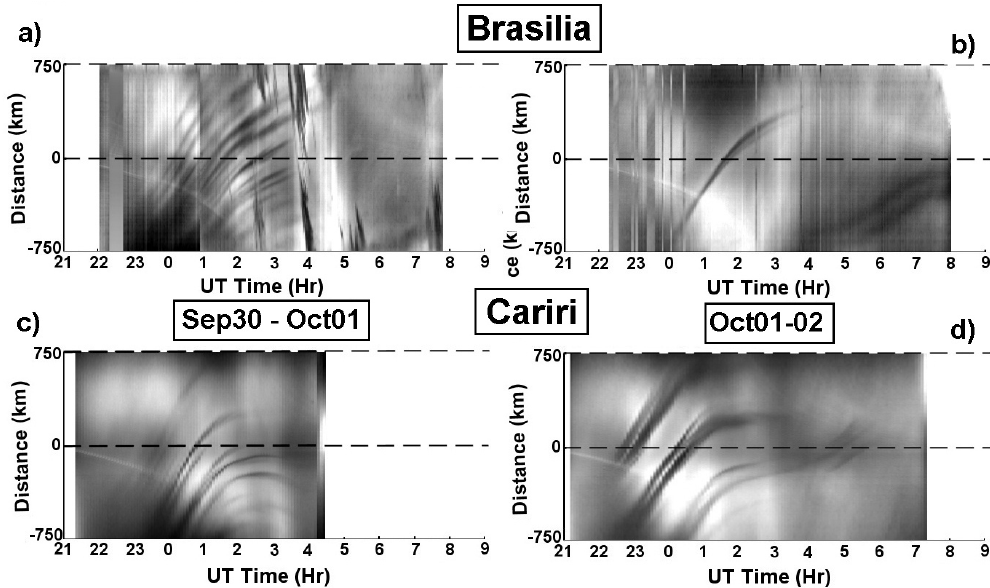
Fig. 8. West-East keograms showing the evolution of the plasma bubbles observed in the OI (630nm) emission from Brasilia (top) and Cariri (bottom) during the nights of 30 September–1 October (left) and 1–2 October (right). The depletions appear as dark bands that are curved due to their change in velocity with